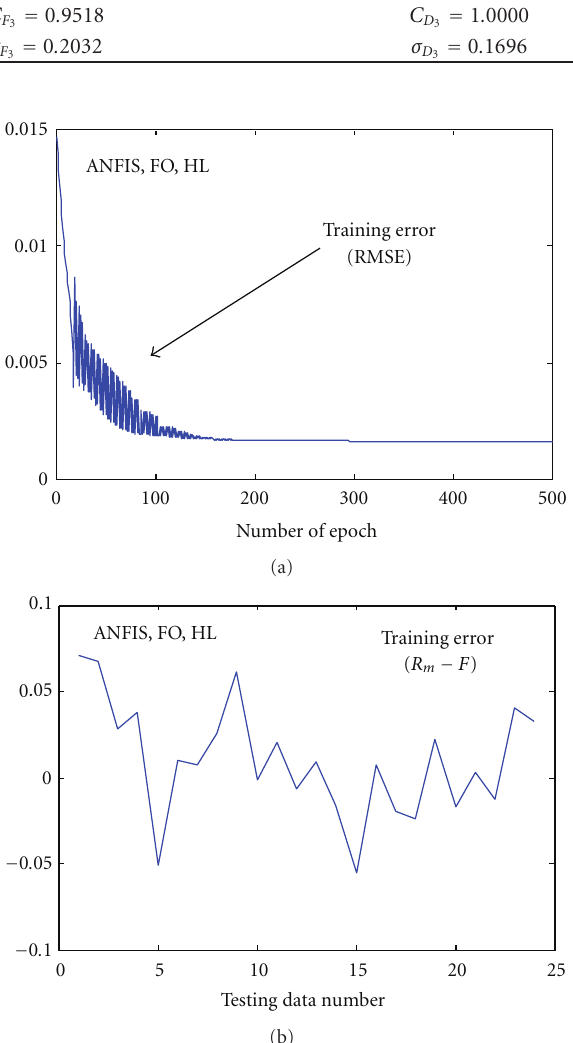
Figure 9: Evolution of the RMSE during the learning phase of FO Sugeno FIS using ANFIS trained with HL algorithm (a) and the resulting prediction error of testing data